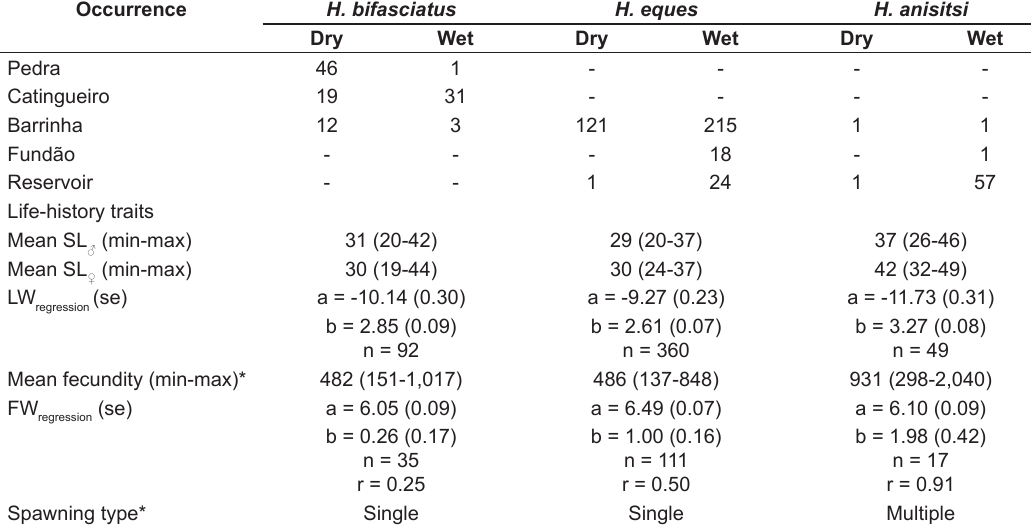
Table 2. Abundance patterns and life-history traits of Hyphessobrycon species. SL males and females, respectively. LW : parameters of the linear regressions between Ln (Length) and Ln (Weight). regression FW : parameters of the linear regressions between Ln (Fecundity) and Ln (Weight). se: standard errors. regression Occurrence